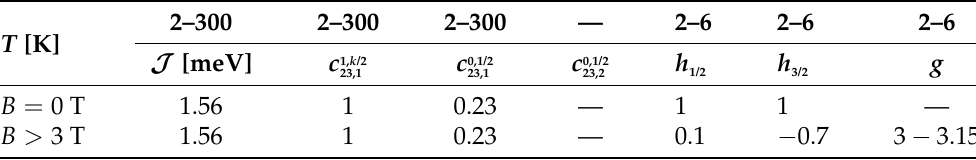
Table 4. List of parameters’ values entering (2) in the case of the compound [(Pc)Er{Pc{N(C 4 H 9 ) 2 } 8 }] − . The first row shows the temperature range according to which the corresponding values are obtained. The exchange J , spectroscopic ‘ c ’ and field ‘ h ’ parameters are fitted with respect to the magnetization data taken from Reference [24] and depicted in Figure 10. Here, k =